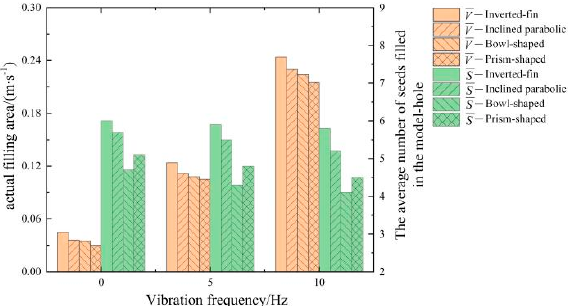
Figure 18. Effect of vibration frequency on the average speed of the population and the average number of grains filled in the actual seed filling area.